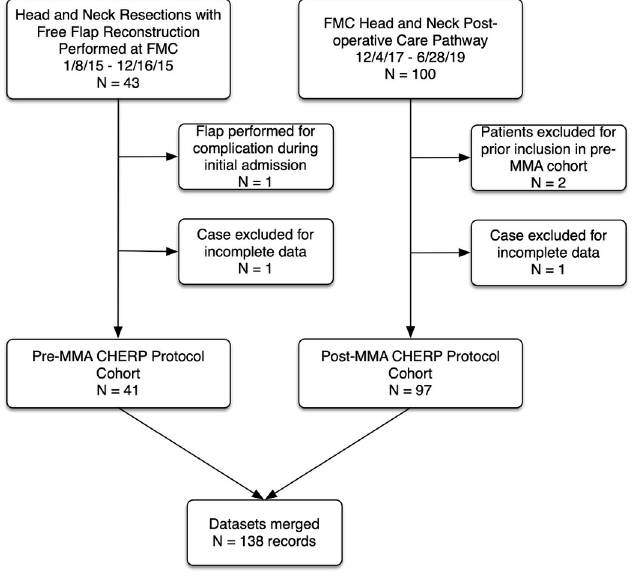
Figure 1. Study flow diagram. CHERP (Calgary Head and Neck Enhanced Recovery Program), MMA (multimodal